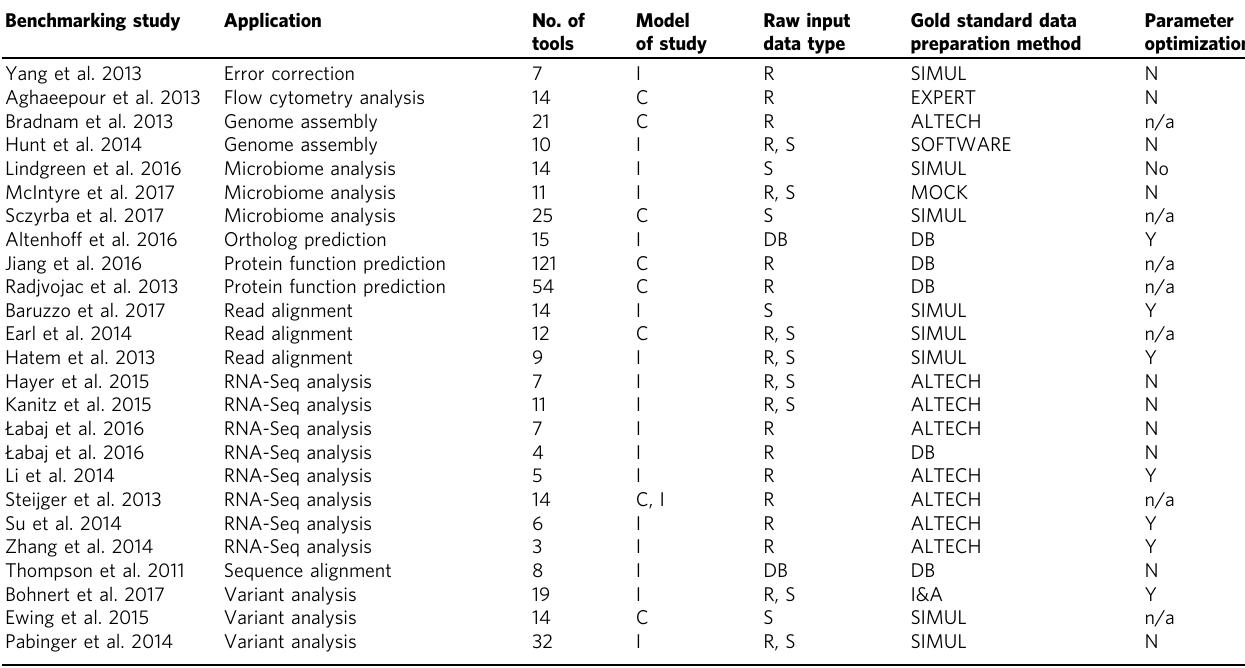
Surveyed benchmarking studies published from 2011 to 2017 are grouped according to their area of application (indicated in column “ Application ” ). We also recorded the number of tools benchmarked byeachstudy( “ Number ofTools ” ).Wedocumentedthe coordinatingmodelused toconductthebenchmarkingstudy( “ ModelofStudy ” ),suchasthoseindependentlyperformedbya singlegroup( “ I ” ), a competition-based approach ( “ C ” ), and a hybrid approach combining elements of “ I ” and “ C ” ( “ C, I ” ). Types of raw omics data ( “ Raw Omics Data ” ) and gold standard data ( “ Gold Standard Data Preparation Method ” ) were documented across benchmarking study. When a benchmarking study uses computationally simulated data, we marked the study as “ S ” ; when real raw data were experimentallygeneratedinthewet-lab,wemarkedthestudyas “ R ” .Whenthestudyusedbothsimulatedandreal data,wemarkedthestudyas “ R,S ” .Goldstandarddatatypesincluded datathatwere computationally simulated (marked as “ SIMUL ” ), manually evaluated by experts (marked as “ EXPERT ” ), prepared by alternative technology ( “ marked as ALTECH ” ), prepared as curated software input (markedas “ SOFTWARE ” ),preparedasmockcommunity(markedas “ MOCK ” ),preparedfromcurateddatabases(markedas “ DB ” ),andpreparedusinganintegrationandarbitrationapproach(marked as “ I&A ” ). In competition-based benchmarking studies, parameter optimization ( “ Parameter Optimization ” ) is performed by each team and is not mandatory (marked here as “ n/a ” ). More details about the characteristics of techniques to prepare gold standard data sets are provided in Table